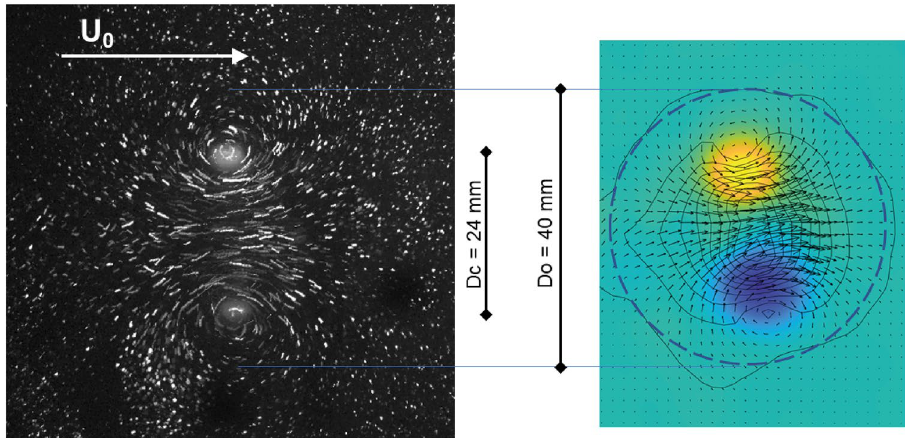
Figure 2. Left: Multiple exposure visualisation of the vortex ring in the horizontal plane. Right: In-plane velocity vector field induced by the travelling vortex ring. The additional contour lines show the velocity magnitude and start from 1/10 U 0 in steps of 1/5 U 0 , where U 0 is the travel speed of the vortex ring. The color- coded vorticity field highlights the cores as regions of highest magnitude of vorticity, which represent the cuts through the toroidal core of diameter D c = 24 mm. The dashed circular ring approximates the outer diameter D o of the ring, beyond which fluid has remained nearly stagnant with velocities lower than 1/10 U 0